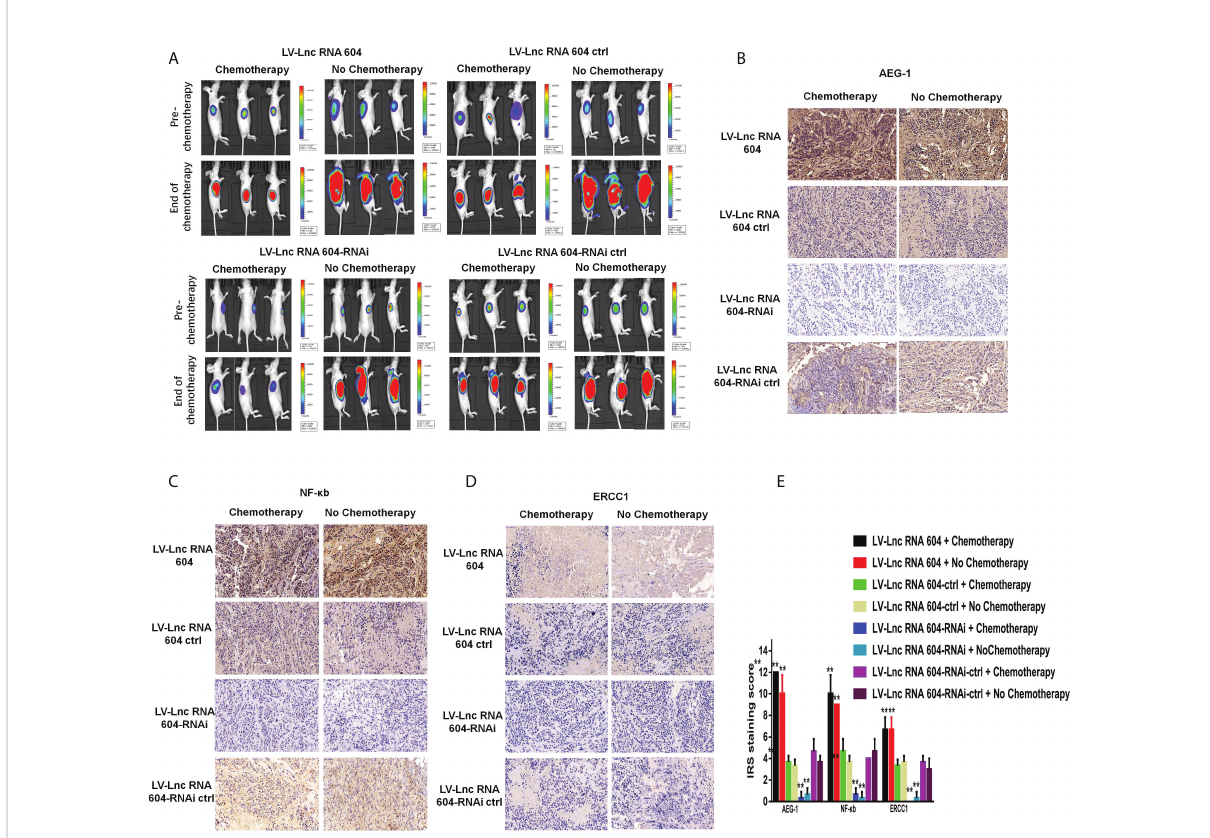
FIGURE 8 LncRNA 604 promoted CRC cell chemoresistance in vivo . (A) The subcutaneous tumors were signi fi cantly smaller in low-expressed lncRNA 604 group while the high-expressed lncRNA 604 group failed to bene fi t, compared with their respective control groups. (B – D) AEG-1, NF- k b, and ERCC1 in subcutaneous tumor were detected by IHC, the trends were the same as WB in vitro (B) AEG-1; (C) NF- k b; (D) ERCC1). (E) The IRS staining score of AEG-1, NF- k b, and ERCC in all groups was graded. All ** P < 0.05. The symbol **** represents the statistical signi fi cance of the two groups: black and red pillars.